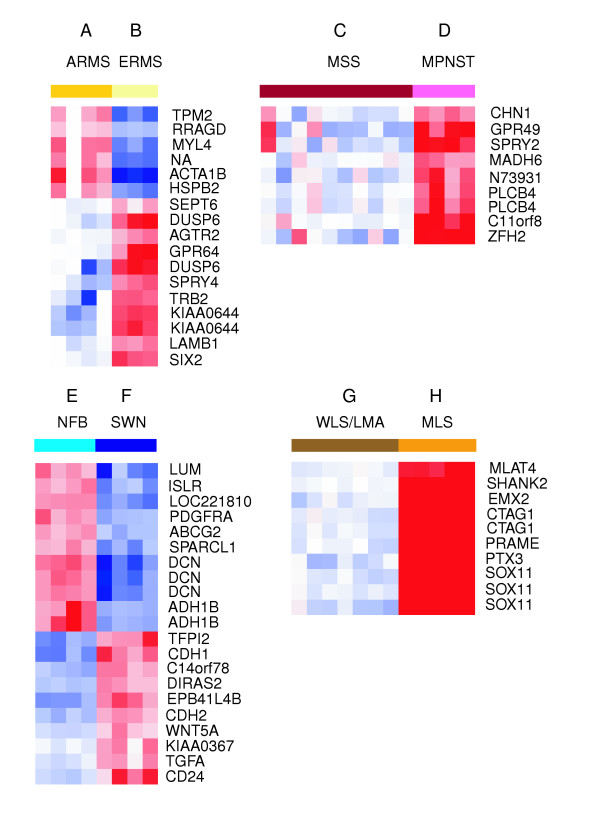
Pathognomonic fingerprints step two. Molecular fingerprints of genes for A and B: ARMS and ERMS; C and D: MSS and MPNST; E and F: NFB and SWN; G and H: WLS/LMA and MLS. We have selected genes based upon their inclusion in the majority of folds of cross-validation then clustered them by average linkage.